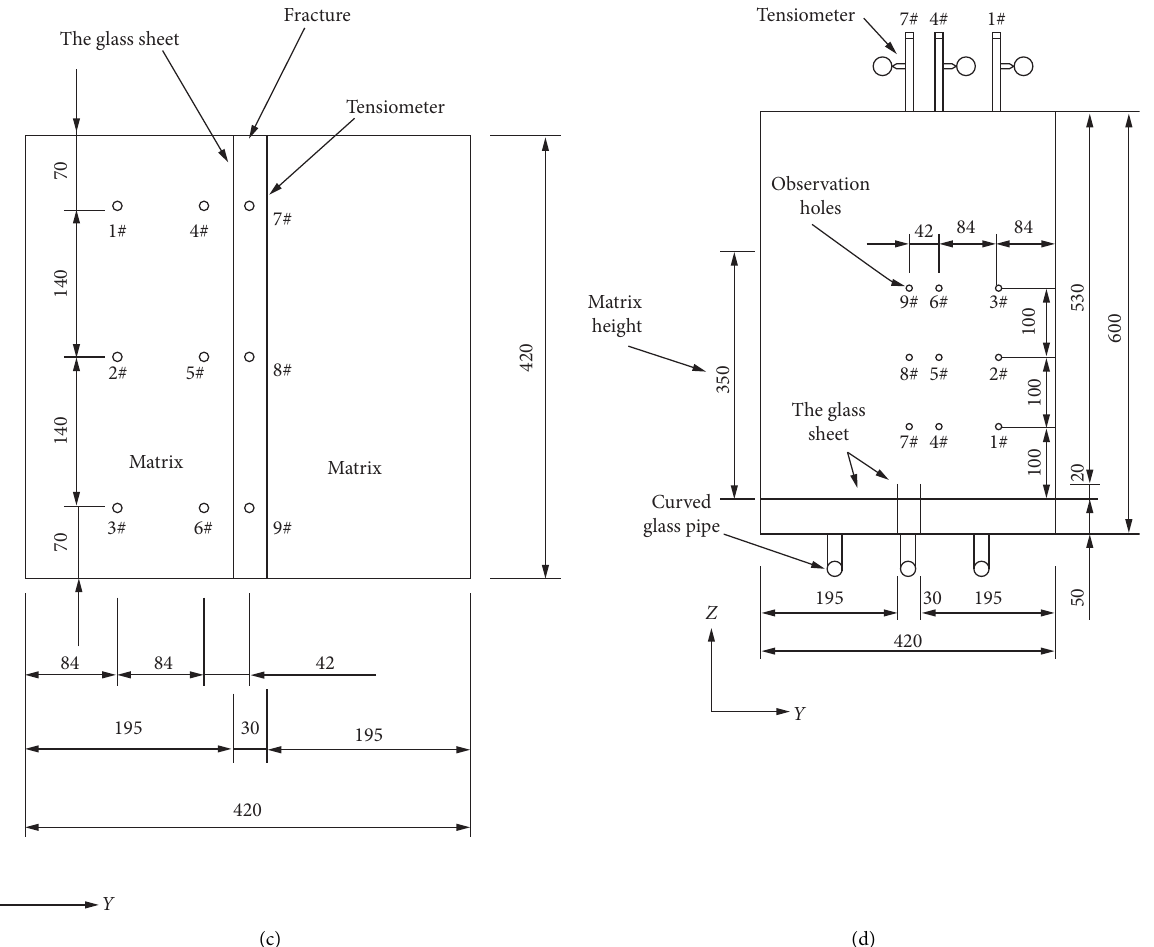
Figure 2: Annotated sketches of the experimental apparatus: (a) sectional view and (b) top view of the water supply tank; (c) top view and (d) sectional view of the sand tank, unit